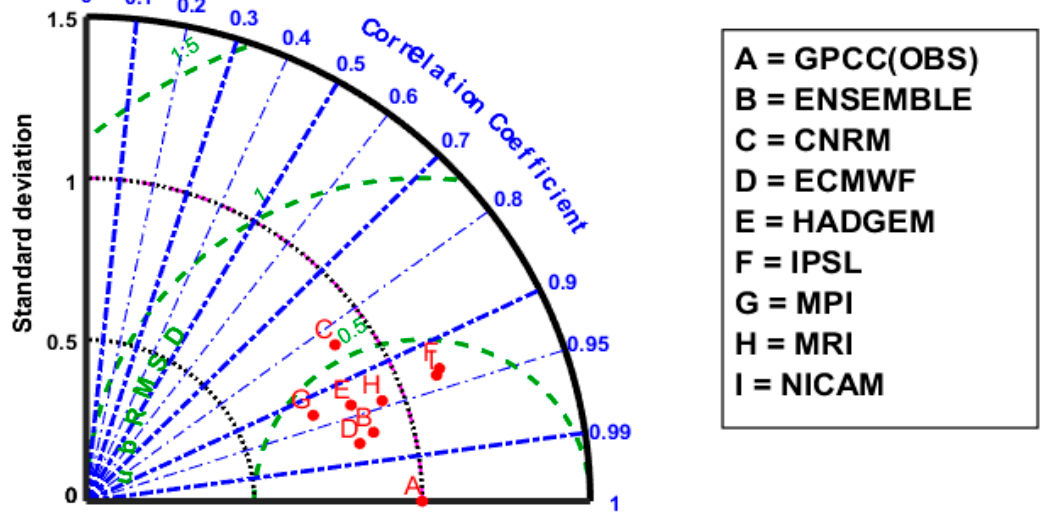
Figure 5. Taylor diagram of mean daily precipitation from June to September of CMIP6, with GPCC as the observation data.